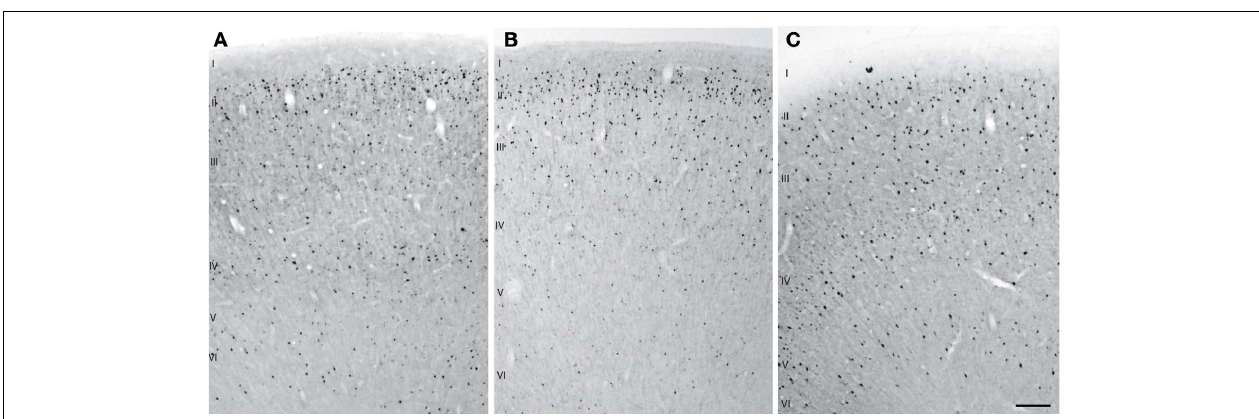
FIGURE 4 | Examples of CB (A), CR (B), and PV (C) immunostaining from layer I through layer VI in baboon parietal cortex. Scale bar = 500